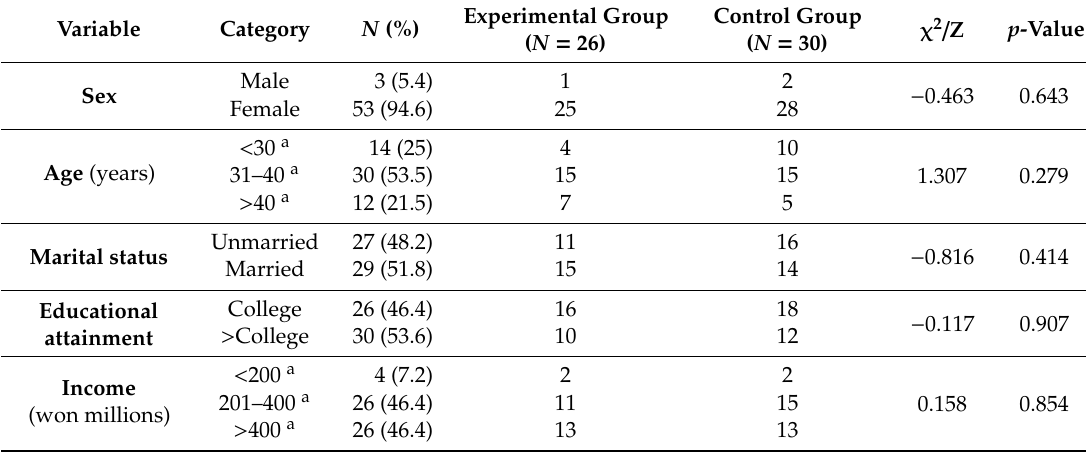
Table 1. Homogeneity tests of personal characteristics ( N = 56).